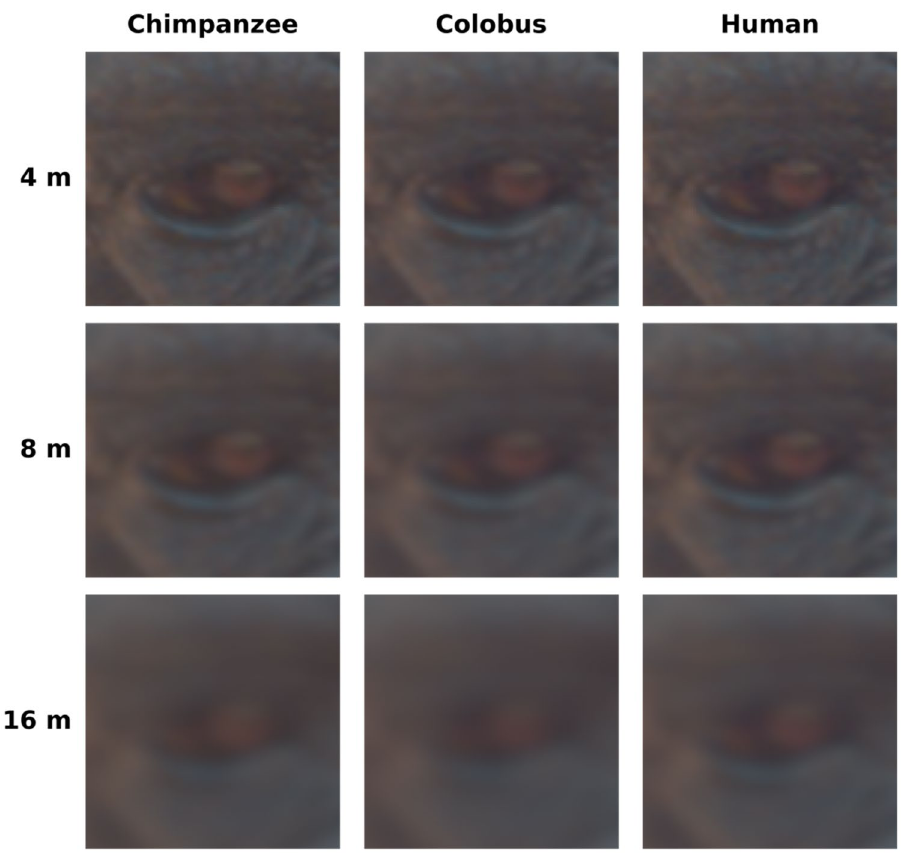
Figure 3. Visualizations of the effect of cone catch conversion and acuity correction steps on a chimpanzee eye as simulated in chimpanzee, colobus, and human vision phenotypes at simulated distances of 4, 8, and 16 m. The human vision phenotype is included only as a point of reference, and was not included in any analyses.